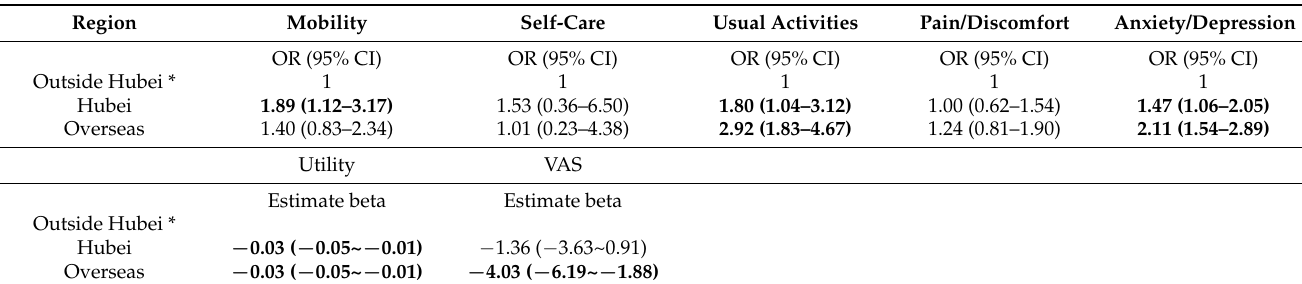
Table 4. Multiple logistic regression analyses on having any problems in EQ-5D dimensions and multiple linear regression analyses on EQ-5D-5L utility and VAS (visual analogue scale) scores, by region, controlled for sex and age group. Region Mobility Self-Care